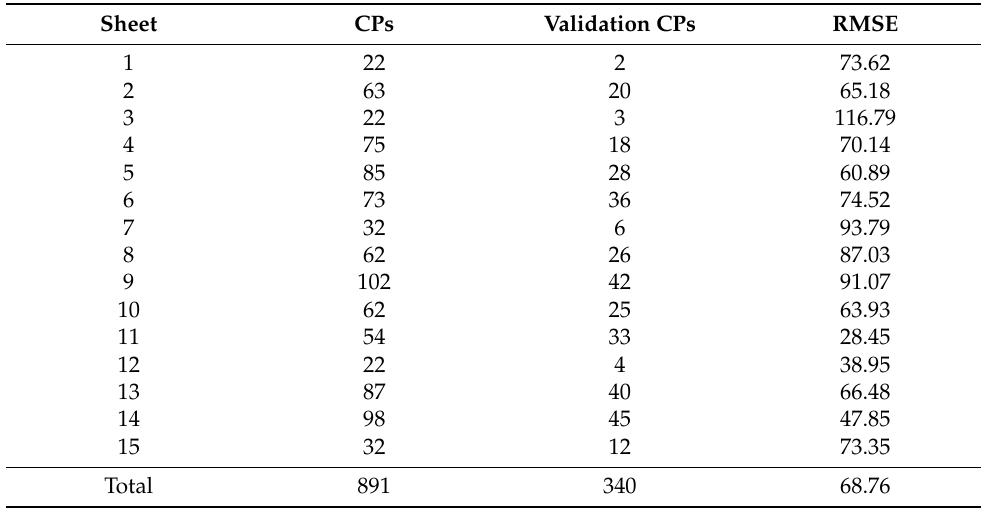
Table 2. Accuracy assessment (RMSE) for each of the 15 sheets of the